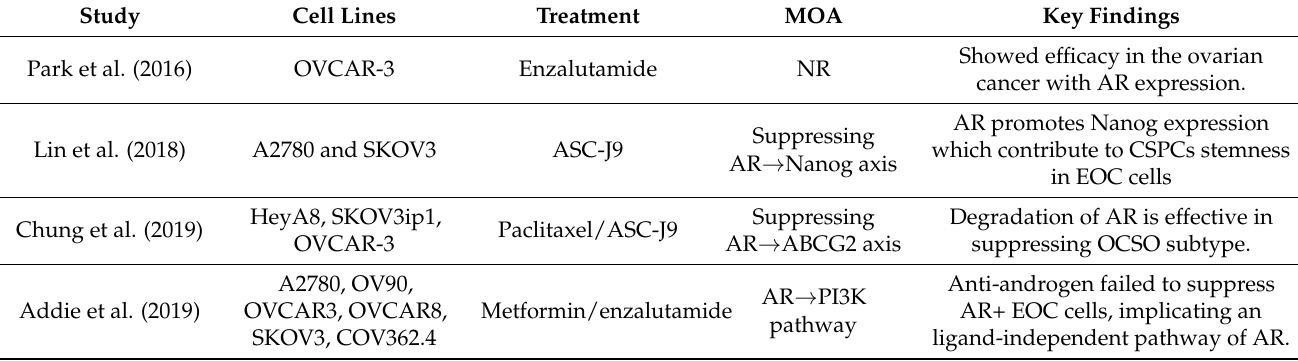
Table 2. Current studies of targeting on androgen/ androgen receptor in ovarian cancer